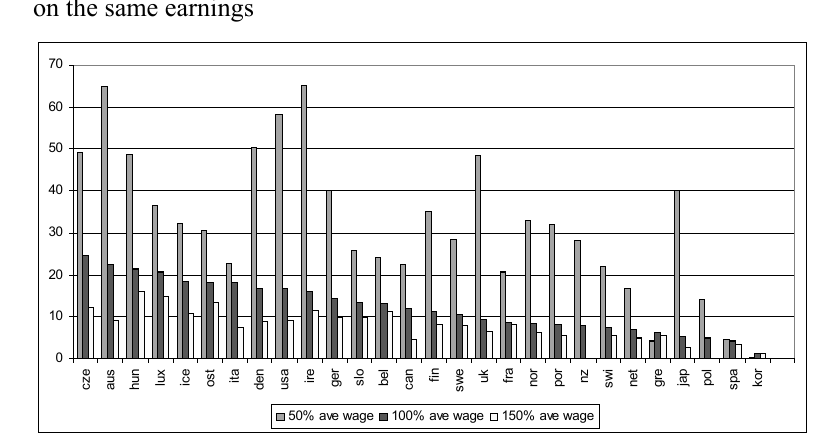
Figure 17 : Child benefit package couple with two children one earner by level of earnings 2005. Ranked by average earnings: % extra over a childless couple on the same